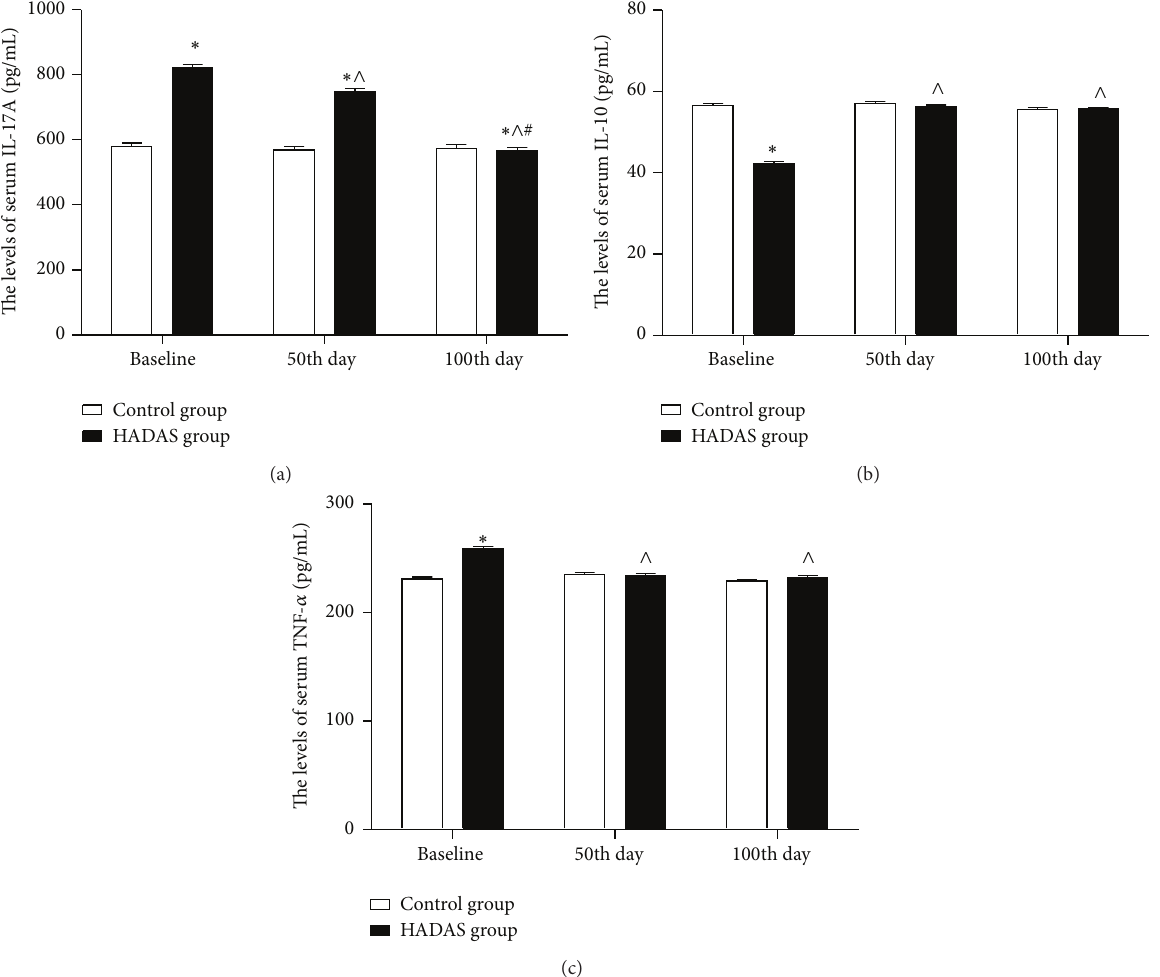
Figure 3: The serum IL-17A, IL-10, and TNF- 𝛼 level of subjects between HADAS and control groups. Data are presented as mean ± SE. IL-17A = interleukin-17A, IL-10 = interleukin-10, and TNF- 𝛼 = tumor necrosis factor- 𝛼 . The serum IL-17A (a), IL-10 (b), and MDA (c) of subjects in both groups were assayed at baseline, 50th day, and 100 day. ∗ 𝑝 < 0.05 , relative to control group, ∧ 𝑝 < 0.05 , relative to baseline, and # 𝑝 < 0.05 , relative to the 50th